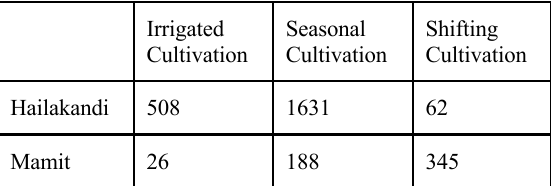
Table 3. Number of land parcels of 25 ha each under various forms of land use for the year